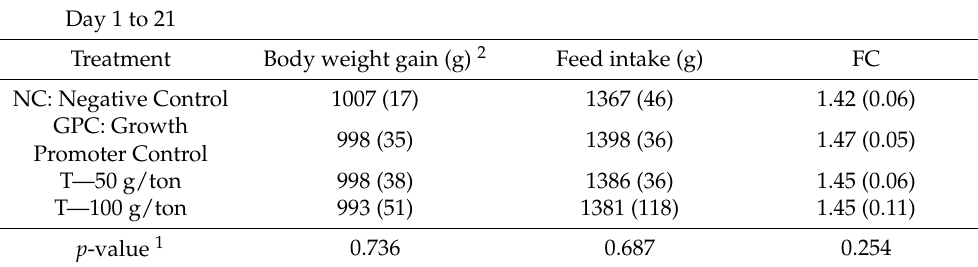
Table 2. Performance (mean and standard deviation) of the broilers fed an antimicrobial blend to replace growth